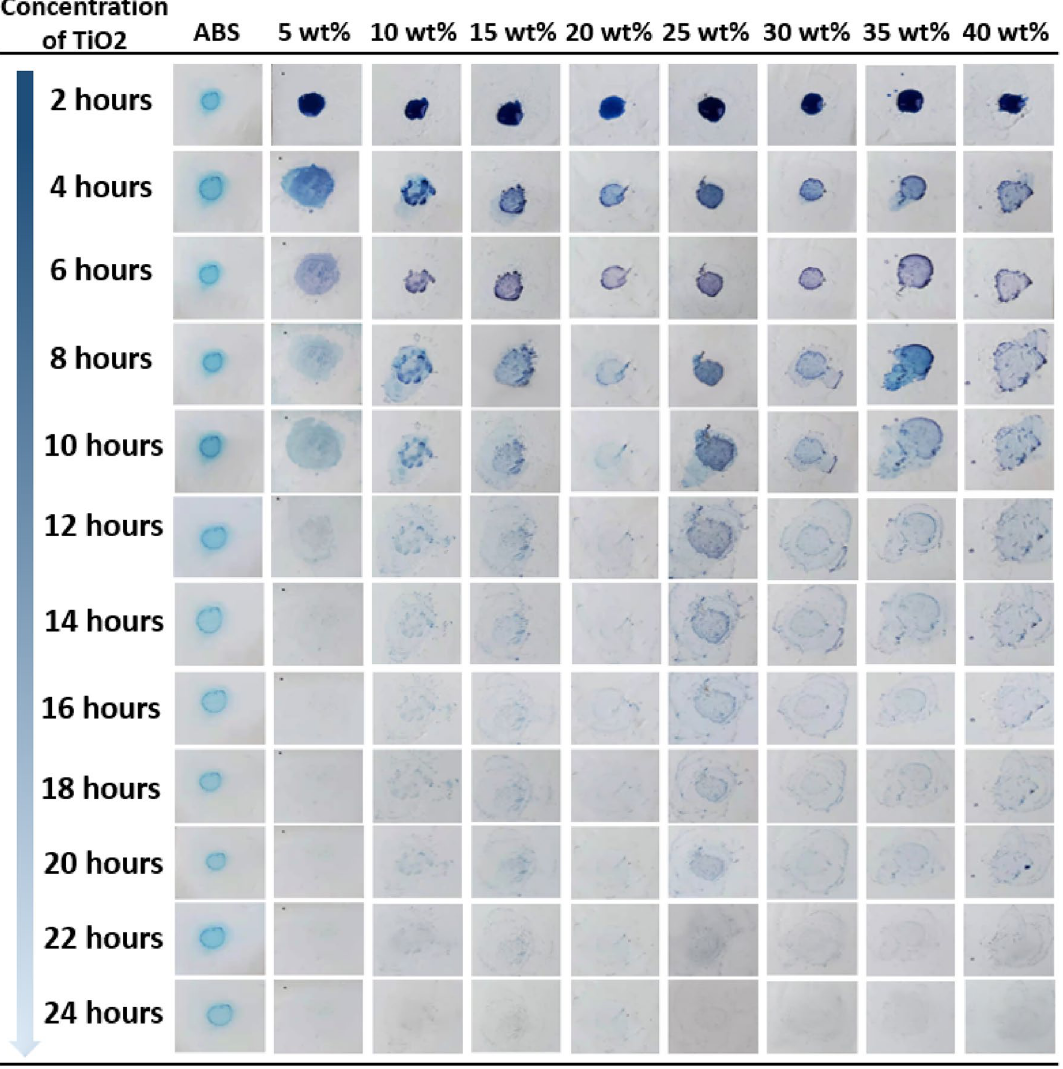
Figure 7. Second cycle photographic images (Contamination point 2) showing the discoloration of methylene blue on SCF specimens in an inside-door environment over 24 h.